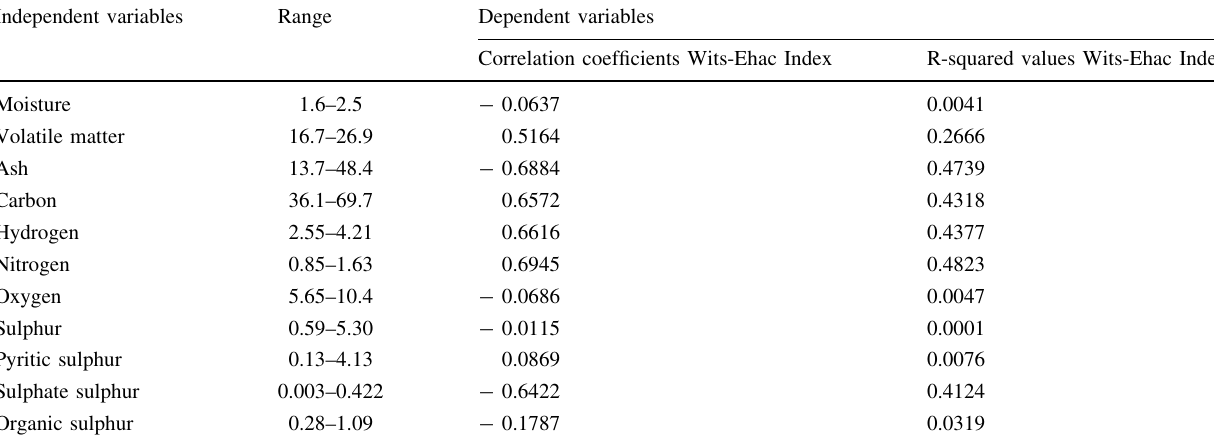
Table 2 Relationships between independent (proximate and ultimate analysis, wt%-ad) and dependent variables for the coal samples Independent